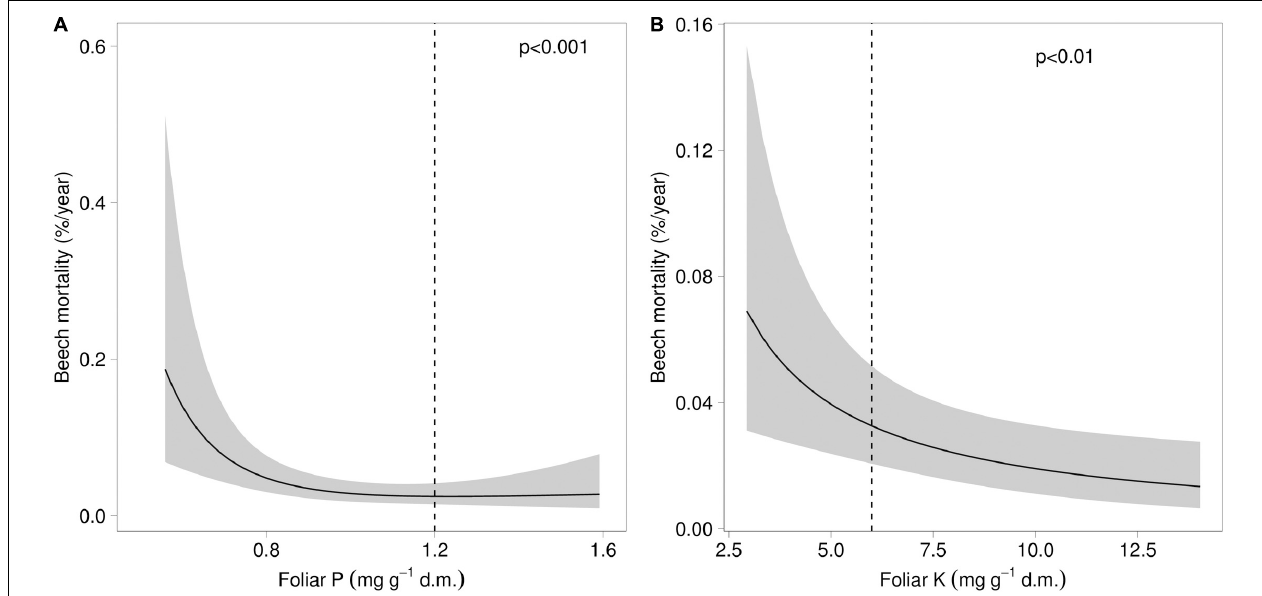
FIGURE 4 | Relation between beech mortality and the concentration of phosphorus (A) and the concentration of potassium (B) in beech leaves. The dashed lines indicate the lower threshold value for normal nutrition according to Göttlein